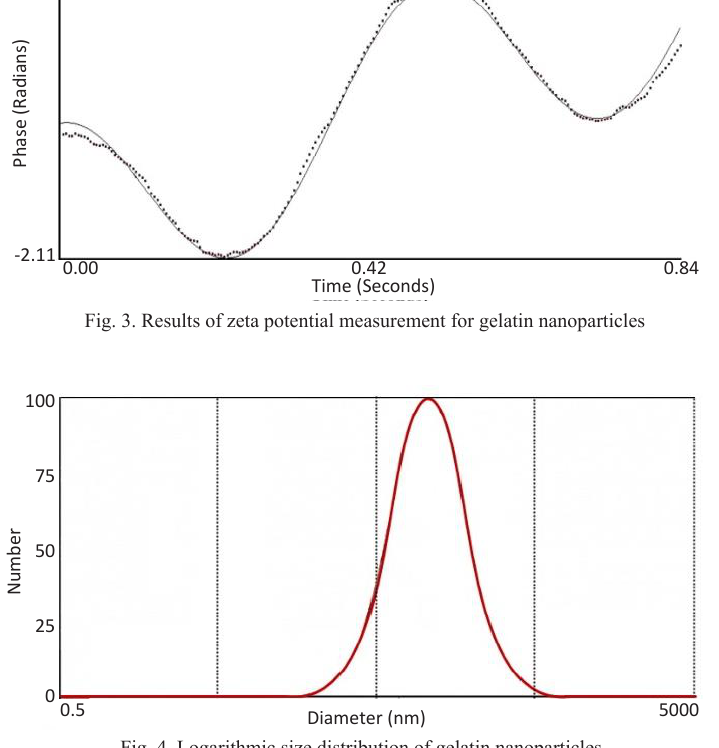
289 J Nanostruct 6(4): 285-292, Autumn